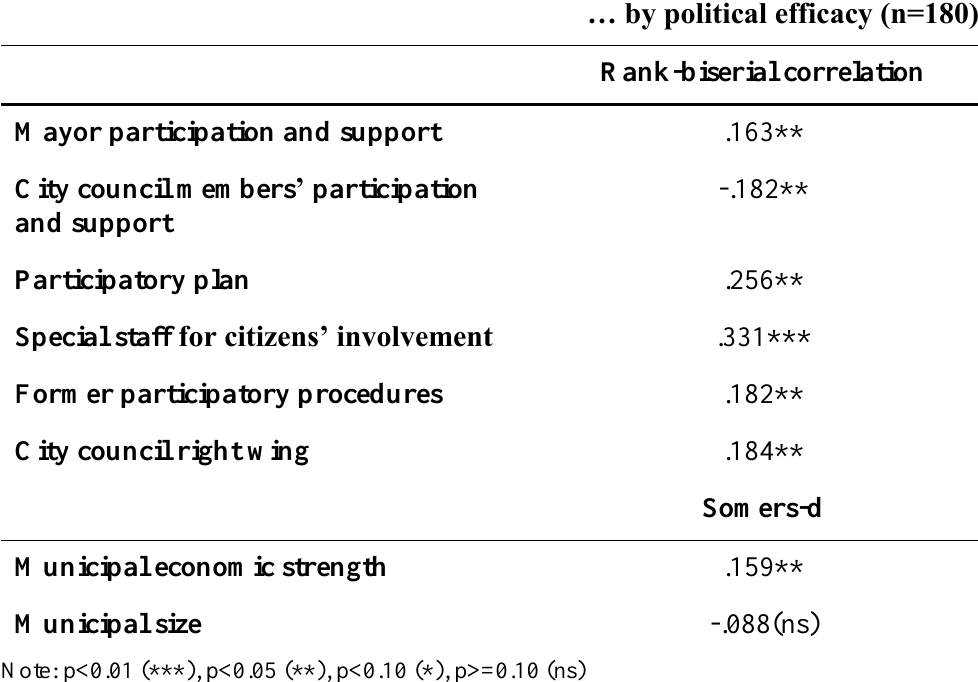
Table 1. Group-related political efficacy, calculation of effect